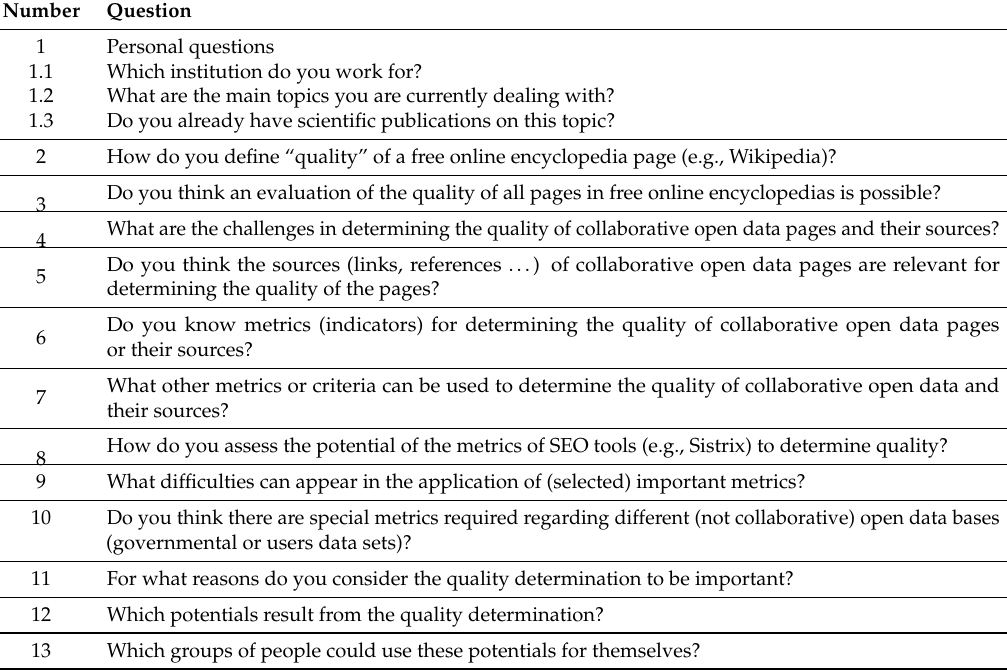
Table A1. Questionnaire for the qualitative interviews “benefits of metrics to determine the quality of collaborative open data pages and their